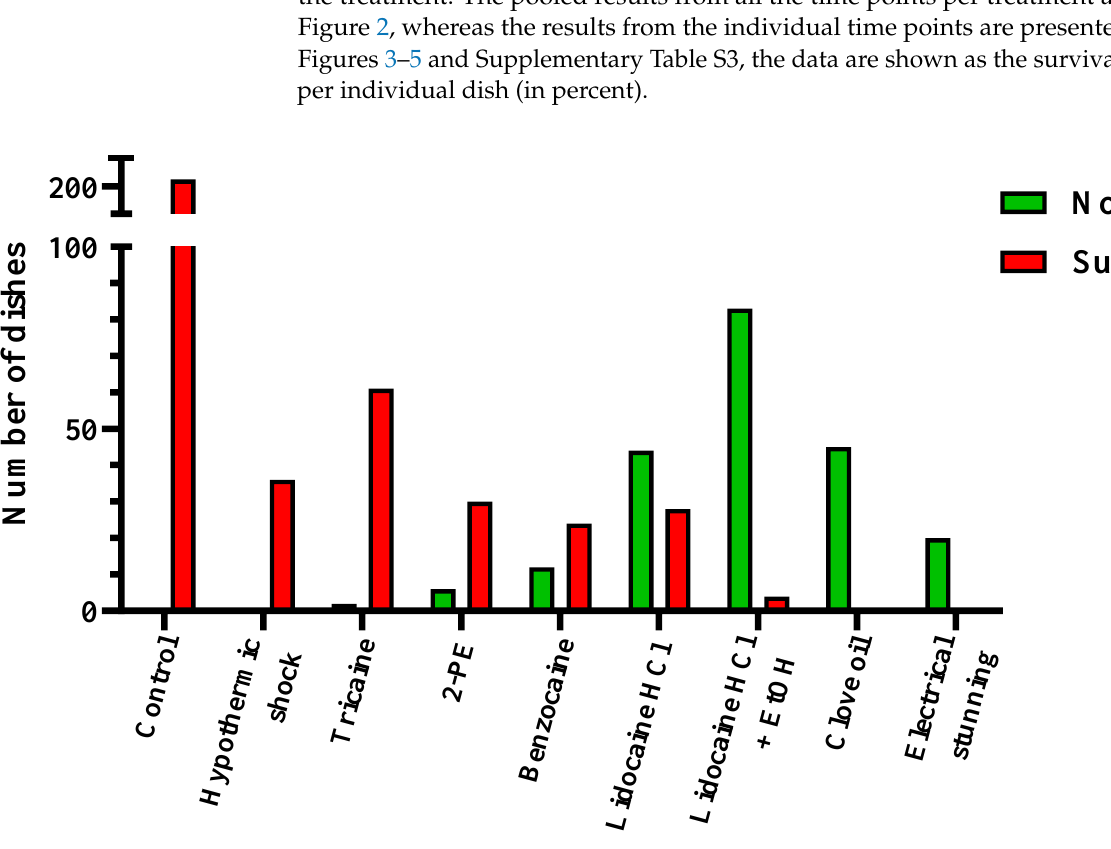
Figure 2. Results for zebrafish embryo and larva euthanasia, presented per experimental dish (results from <12 h post fertilization, 24 h post fertilization, and 4 days post fertilization pooled, n = 20–202). The dishes in which treatments lead to no surviving embryo or larva were scored as “passed” (green), whereas the dishes with one-or-more surviving embryos or larvae were scored as “failed” (red). For the results per individual time point, see Table 4.